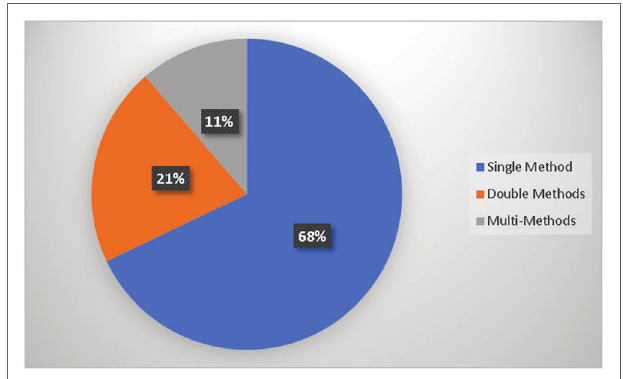
FIGURE 6 | Summary of methods.